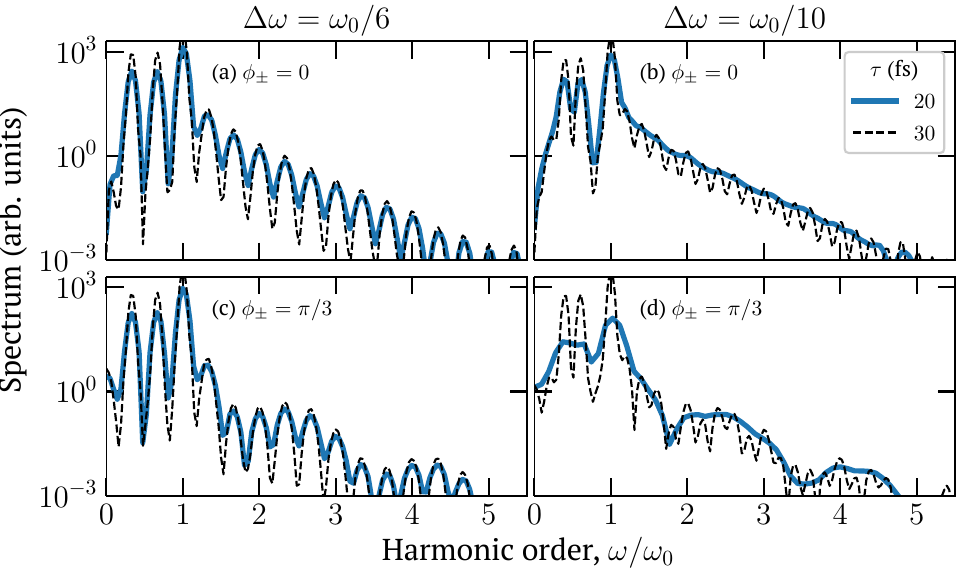
Figure 2. d j / dt squared spectrum from three-color ionizing pulses with ω 0 corresponding to ∆ ω with two different values of ∆ ω = ω = ω 0 /2 λ 0 = 800 nm, ω 0 /6 ( a , c ) and ω 0 /10 ( b , d ) ± ± = 0 ( a , b ) and ϕ + = ϕ = π /3 ( c , d ). Intensities and two different values of phases ϕ + = ϕ − − = 2 I 0 = 10 15 W/cm 2 and I + = I 10 14 W/cm 2 . Blue lines correspond to pulse duration × − τ p = 20 fs, dashed black lines to τ p = 30